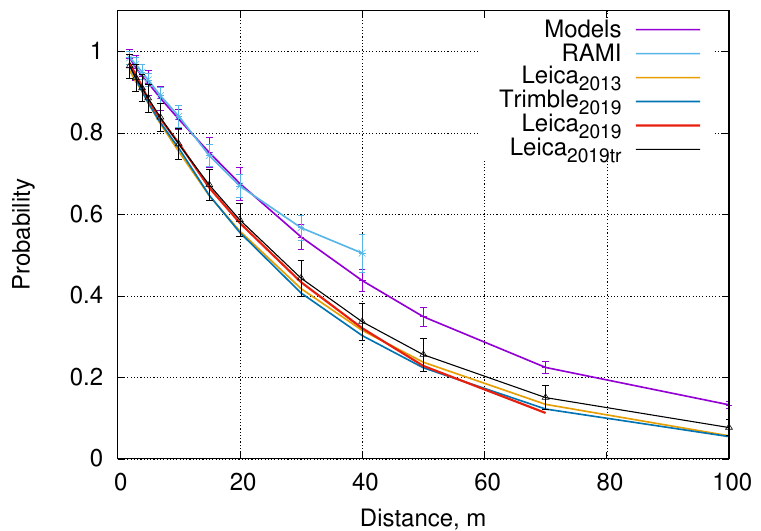
Figure 2. Pine stand: probability of free line of sight as computed from the generated tree pattern models, as computed from measured tree positions and measured stem diameters (RAMI database), and as estimated from the TLS point clouds generated by three different scanners in four different field sessions. Error bars indicate standard